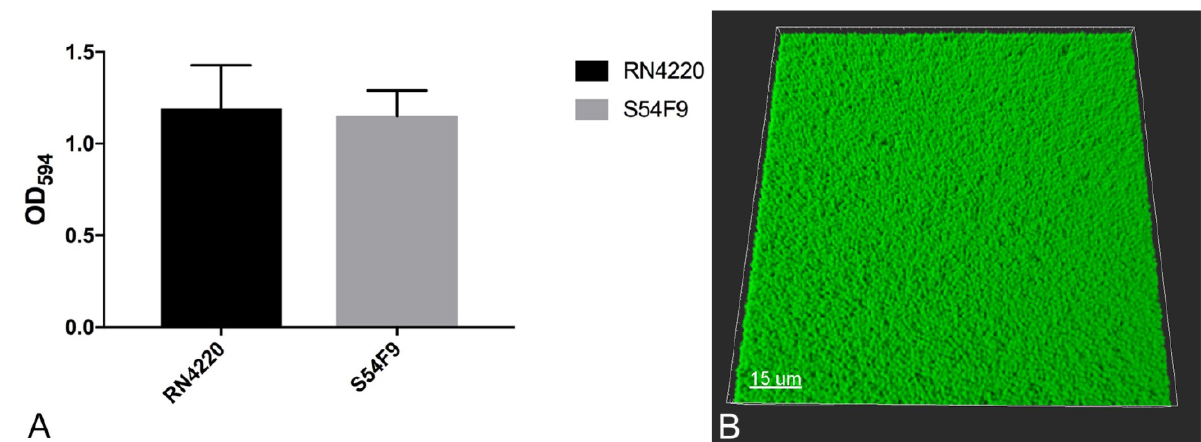
Figure 2. Biofilm formation in vitro . A: Attached biomass of reference strain RN4220 and S54F9 in the wells of microtiter trays based on the binding of crystal violet. Mean OD 594 with SEM. B: 3D projection of the bottom of a microtiter well stained for bacterial cells with green Syto9. 630 x